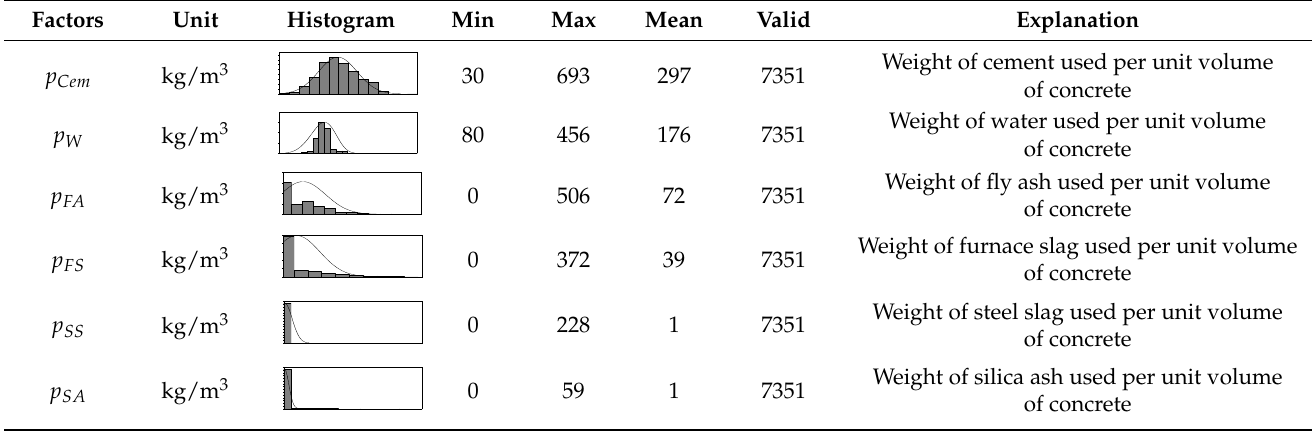
Table 1. Details of the dataset.